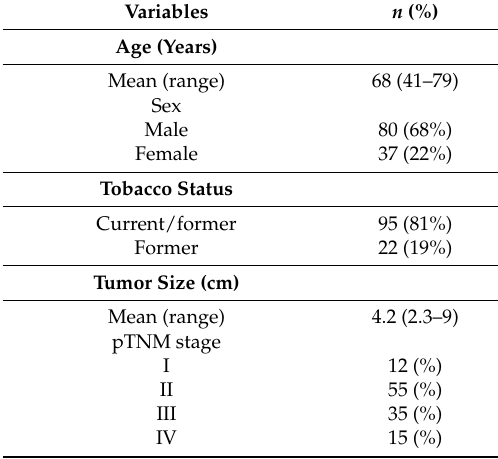
Table 3. Main epidemiological parameters associated with the cohort of lung sarcomatoid carcinoma patients (total of 117